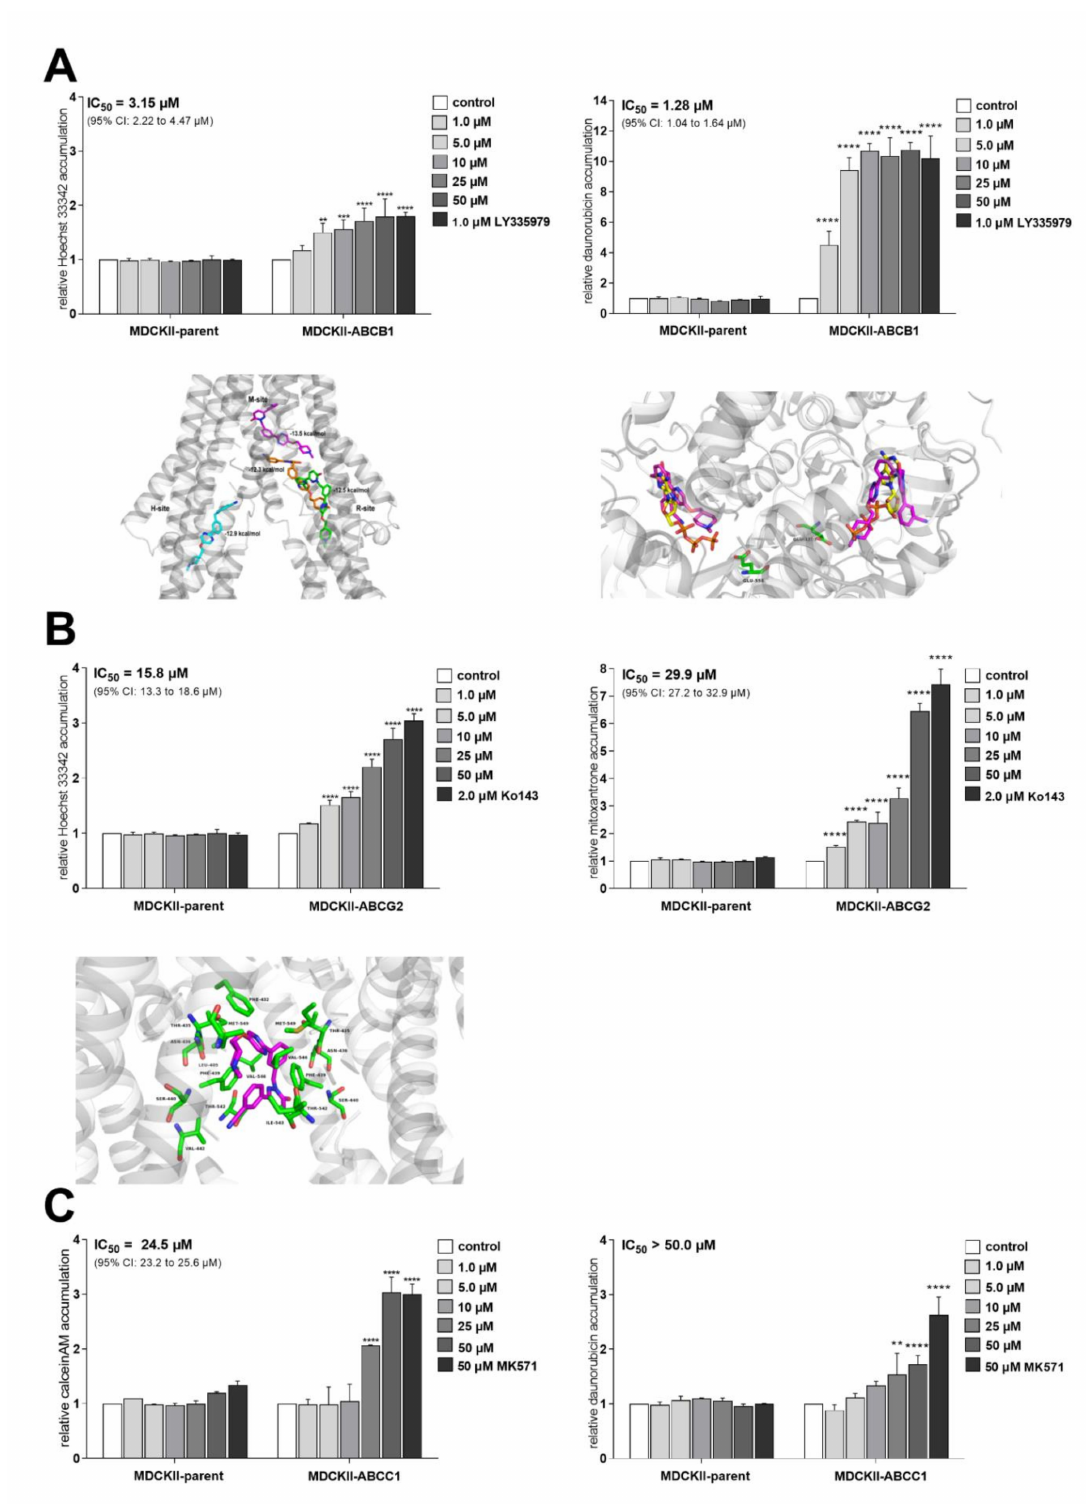
Figure 1. Effect of tepotinib on the activity of MDR-associated ABC transporters in vitro and in silico. Graphs from accumulation assays in (( A ) up ) MDCKII-ABCB1, (( B ) up ) MDCKII-ABCG2 and ( C ) MDCKII-ABCC1 cells are shown along with the results from (( A ) bottom ) ABCB1 and (( B ) bottom ) ABCG2 docking. Tepotinib is depicted as (( A ) bottom left ) colored sticks or (( A ) bottom right and ( B ) bottom left ) magenta sticks; (( A ) bottom right ) ATP molecules that originally co-crystallized with the protein backbone are shown as yellow sticks; (( A ) bottom right and ( B ) bottom left ) interacting amino acid residues as green sticks and are